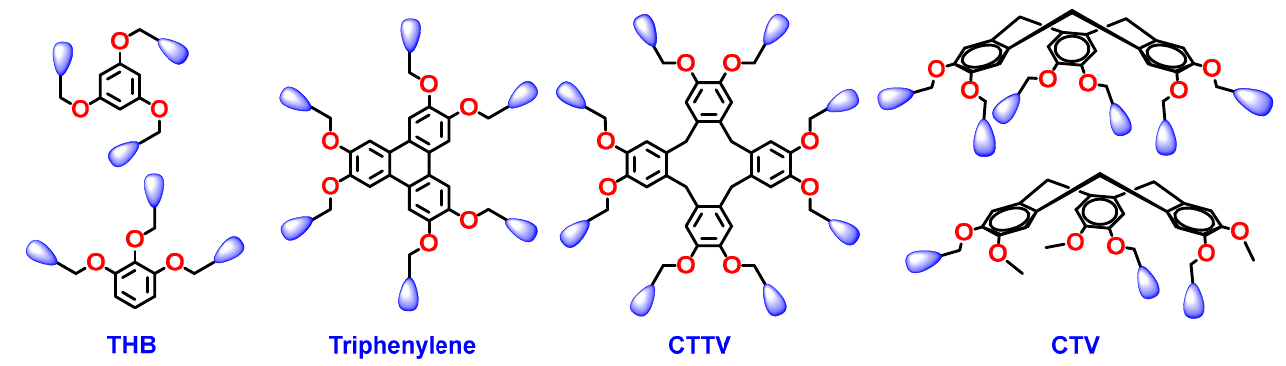
Figure 12. Examples of constitutional isomerism of the focal point. 1,3,5-trihyhdroxybenzene (THB), triphenylene, cyclotetraveratrylene (CTTV), cyclotriveratrylene (CTV).